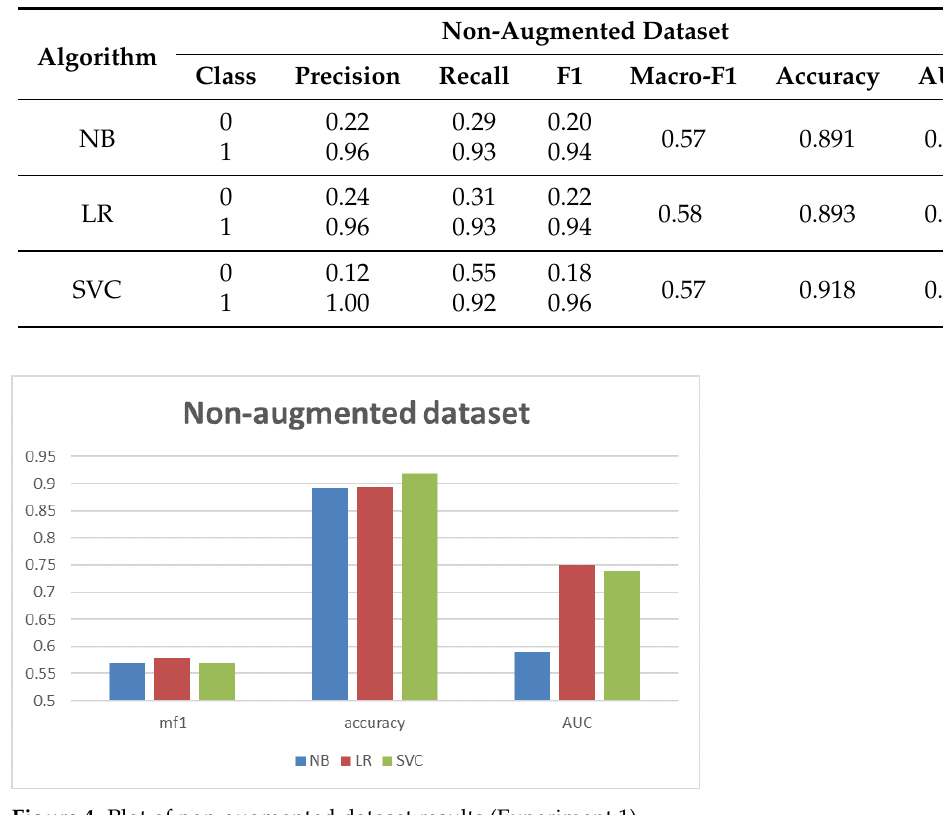
Figure 4. Plot of non-augmented dataset results (Experiment